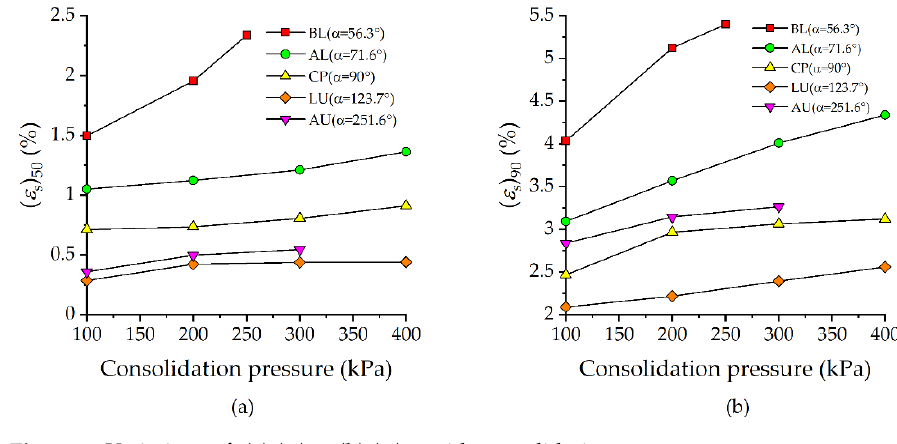
Figure 8. Variations of: ( a ) ( ε s ) 50 ; ( b ) ( ε s ) 90 with consolidation pressure.